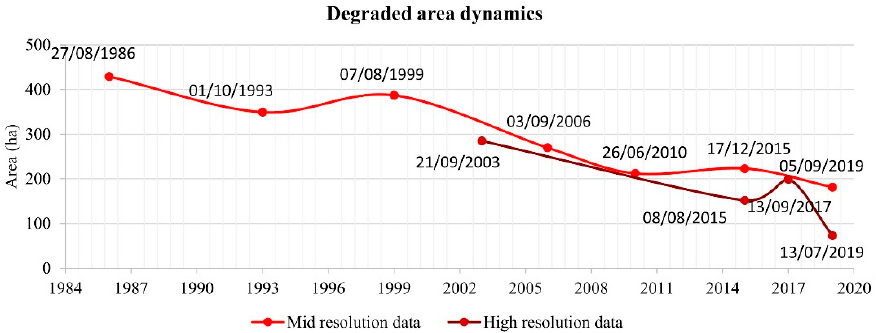
Figure 8. Degraded mangrove areas using mid and high-resolution images between 1986 and 2019. Differences in the mid and high-resolution degraded areas, for instance in 2015, may be attributed to the mid-resolution sensors of the Landsat that tend to unify the spectral response